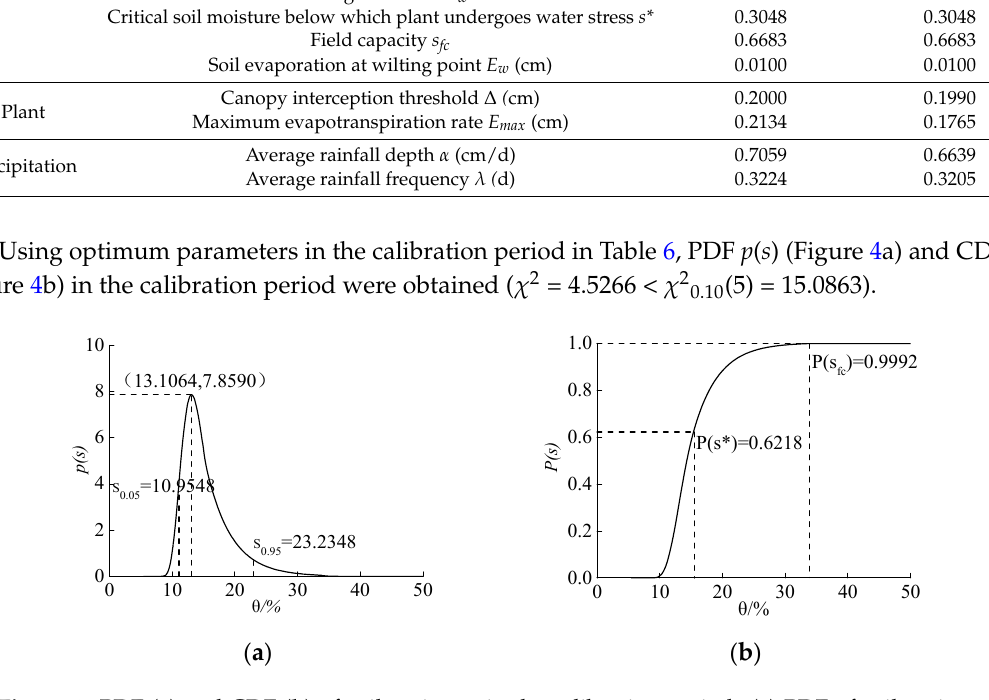
Figure 5. Daily average soil moisture in the calibration period.